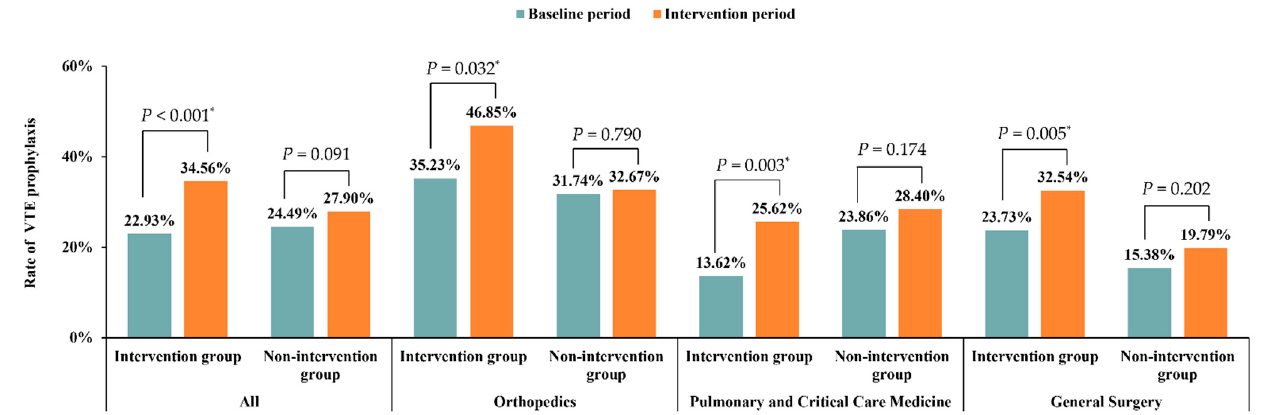
Figure 4. Improvement of VTE prophylaxis in different departments. * p < 0.05.